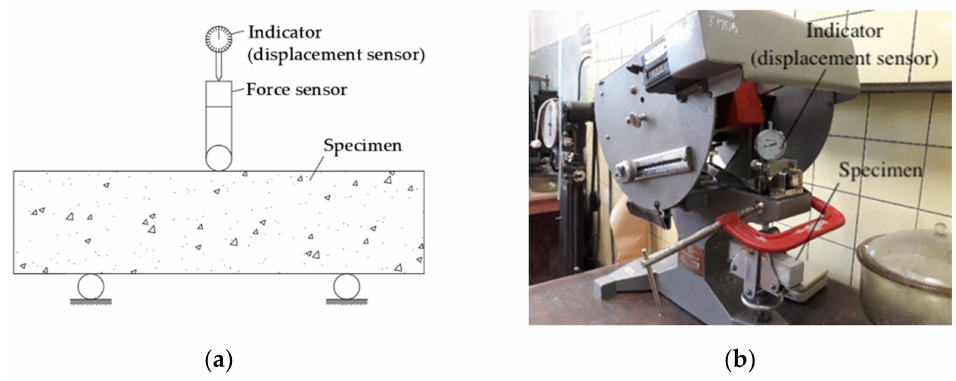
Figure 2. Setup for determining the strength and deflection in bending. ( a ) Testing scheme; ( b ) external view of the